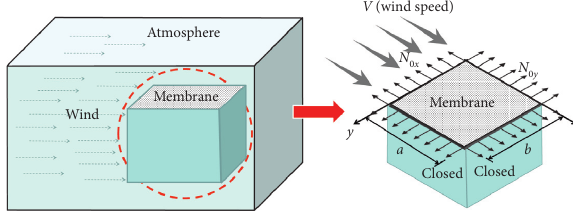
Figure 2: The membrane roof on closed